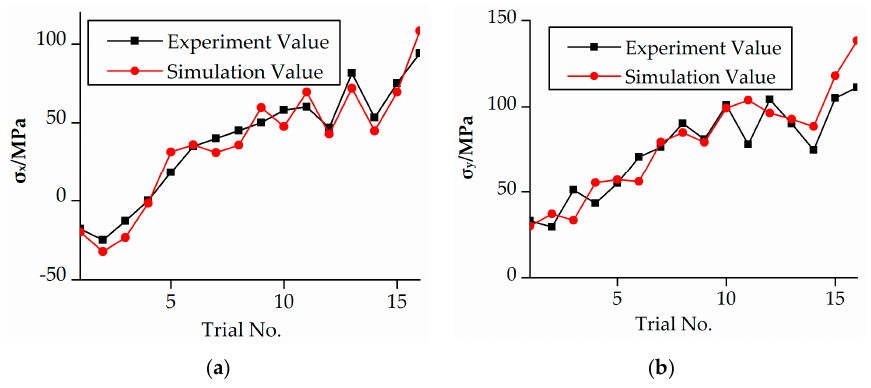
Figure 2. Comparison of simulation and experiment results. ( a ) X -direction; ( b ) Y -direction.